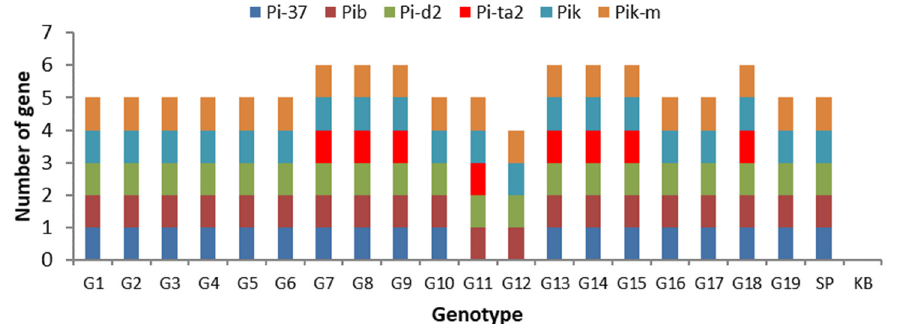
Figure 5. The presence of blast-resistant genes, indicated by rice lines; the red color indicates a Pita2 gene, which is a unique protein essential for broad-spectrum disease resistance.